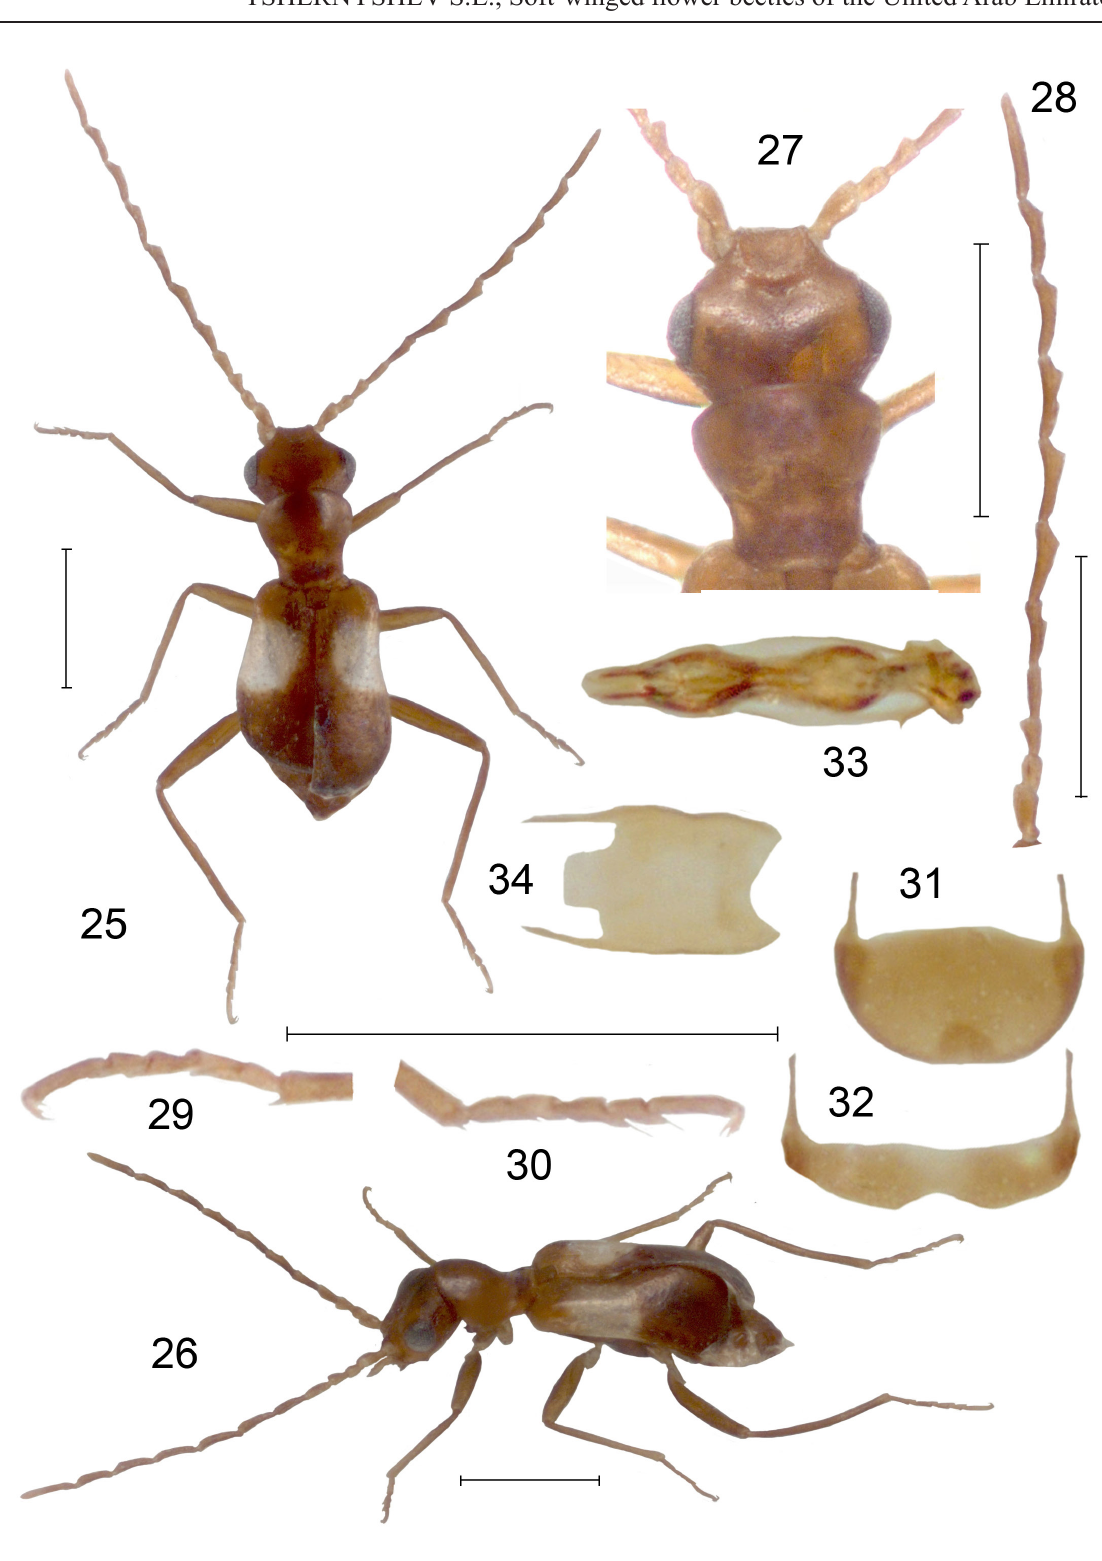
Figs 25–34. Arabotroglops longantennatus gen. et sp. nov., holotype (SCH_ISEA_000164), ♂. 25 . External appearance, dorsal view. 26 . External appearance, lateral view. 27 . Head and pronotum, dorsal view. 28 . Right antenna. 29 . Right anterior tarsus. 30 . Left anterior tarsus. 31 . Pygidium. 32 . Ultimate abdominal ventrite. 33 . Aedeagus, dorsal view. 34 . Tegmen. Scale bars: 0.5